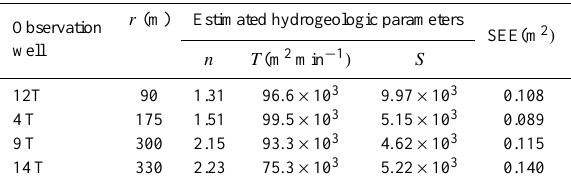
Table 4. The parameters estimated by weighted least squares. Observation